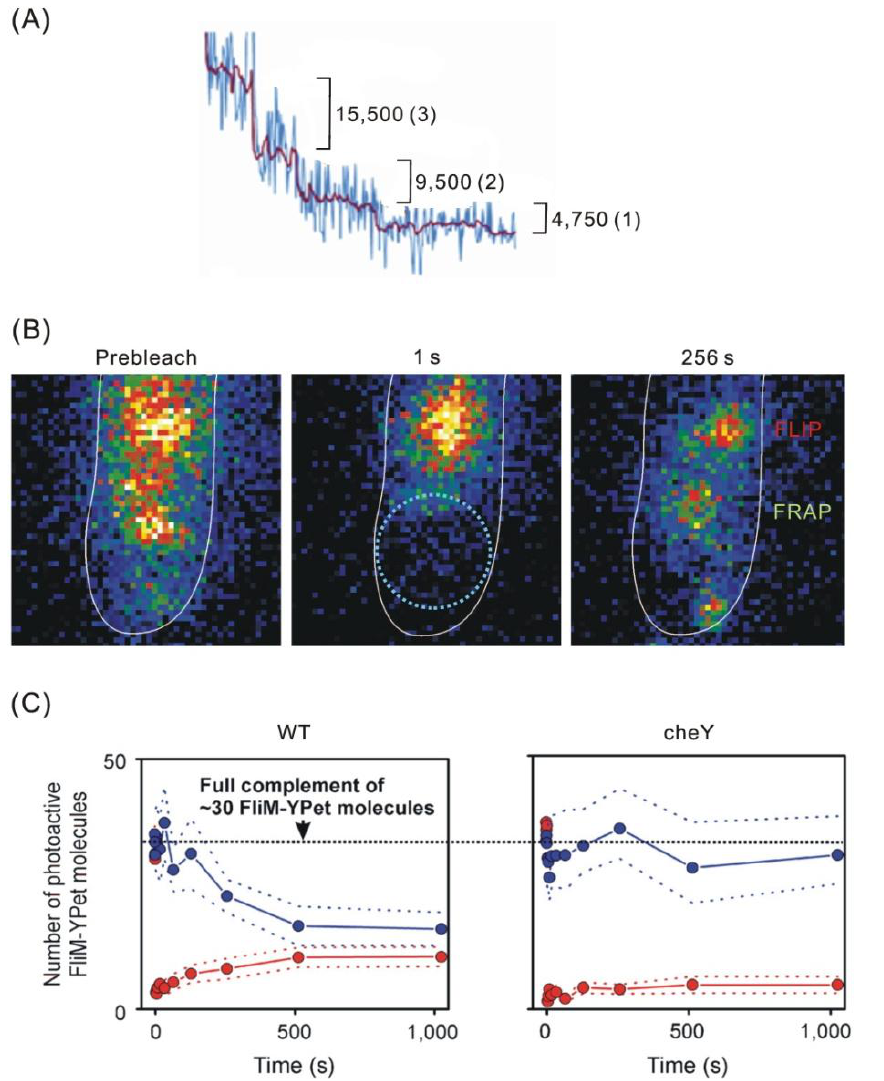
Figure 6. Stoichiometries and dynamics of a functioning flagellar nanomachine in living bacterial cells. ( A ) Stepwise photobleaching of GFP–MotB molecules in a motor after prebleaching of the cell to reduce background. Shown are the raw motor intensity (blue), Chung-Kennedy filtered motor intensity trace (red), and detected steps (in parentheses) and step sizes; ( B ) Successive TIRF images of a cell region before and after photobleaching. The boundary of the laser focus is indicated (dotted circle, middle panel). FLIP (red) and FRAP (light green) of GFP–MotB molecules of two motors are shown. The cell is outlined (white) [76]; ( C ) Turnover of FliM molecules in the switch complex is dependent on the response regulator CheY. Mean FRAP (red) and FLIP (blue) traces (dotted lines: SEM error bounds) based on 7–11 spots are shown for FliM-YPet in WT and Δ cheY cells